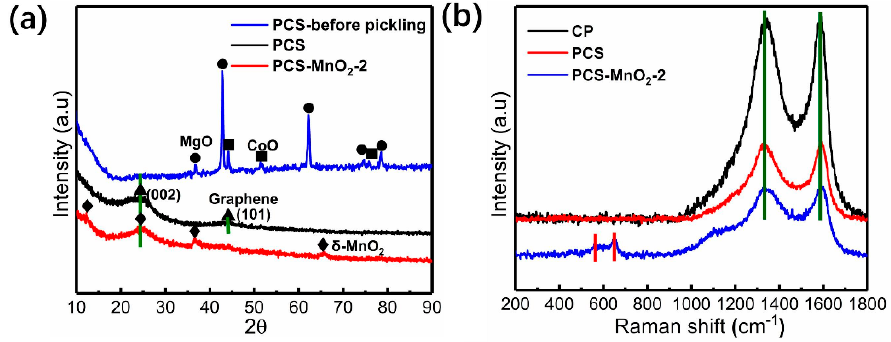
Figure 3. ( a ) XRD patterns of carbon product prepared from directly carbonized